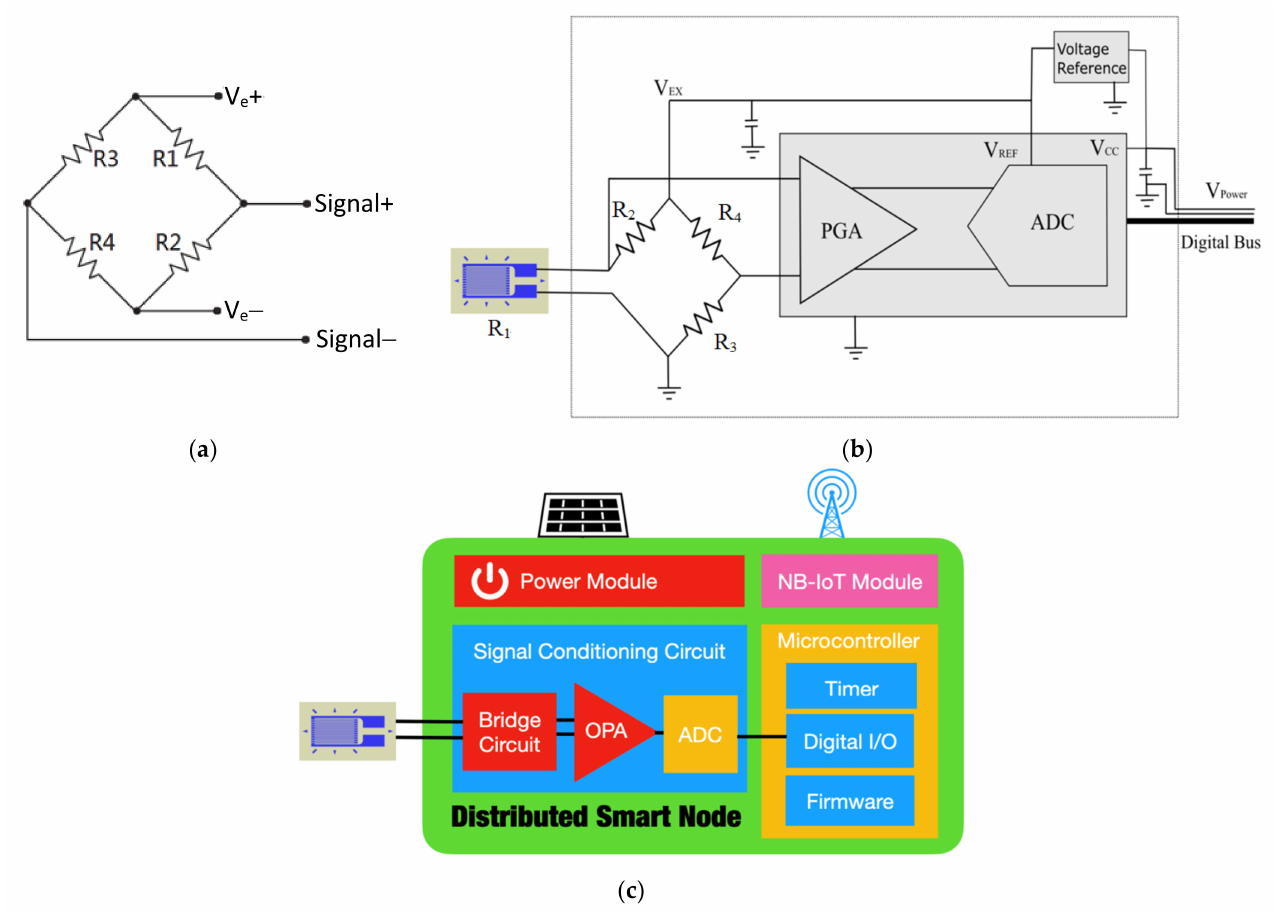
Figure 10. Smart node: ( a ) Wheatstone bridge; ( b ) data acquisition circuit; ( c ) smart node